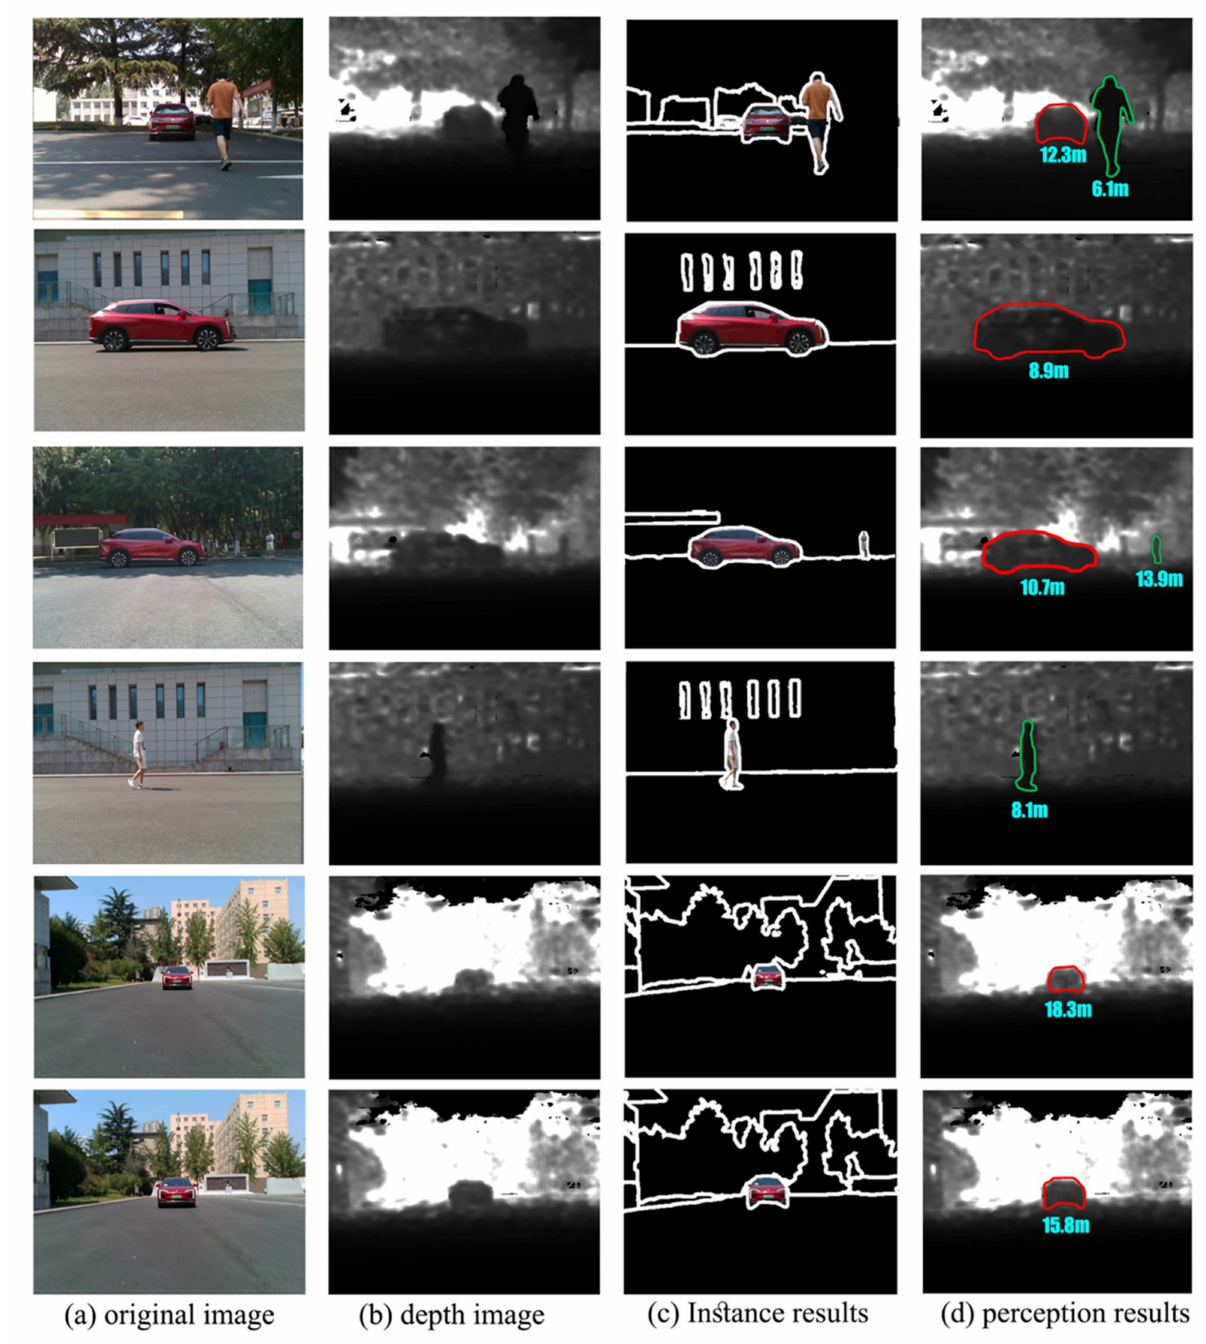
Figure 8. The results of target